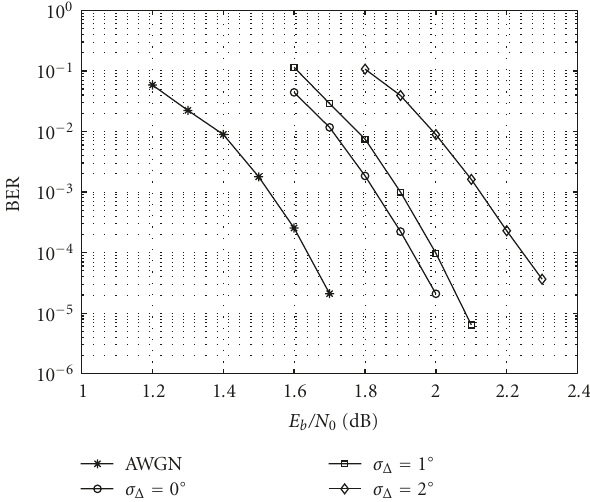
Figure 5: Performance of the proposed receiver in Figure 3 with QPSK and the Wiener phase model.